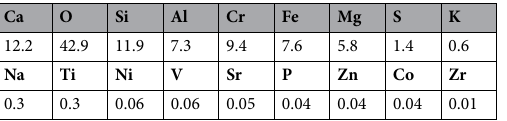
Table 1. Elemental composition of the original chromium-contaminated soil.